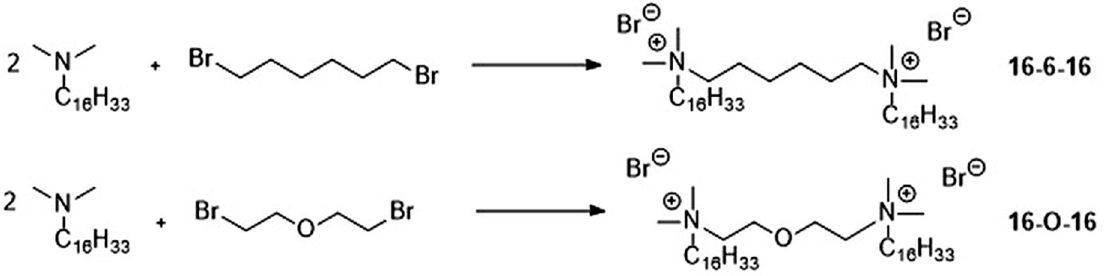
Figure 1. Synthesis of 16-6-16 and 16-O-16.